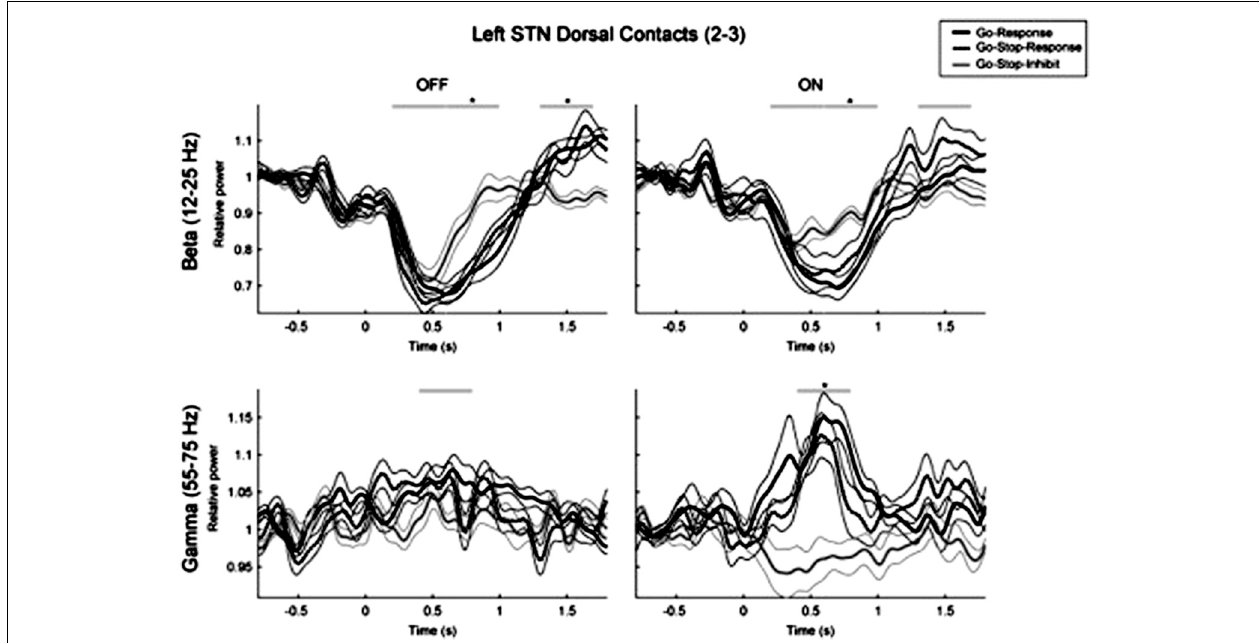
FIGURE 6 | The changes in the gamma band activity in local field potentials recorded from the implanted electrodes in the subthalamic nucleus when patients with Parkinson’s disease were